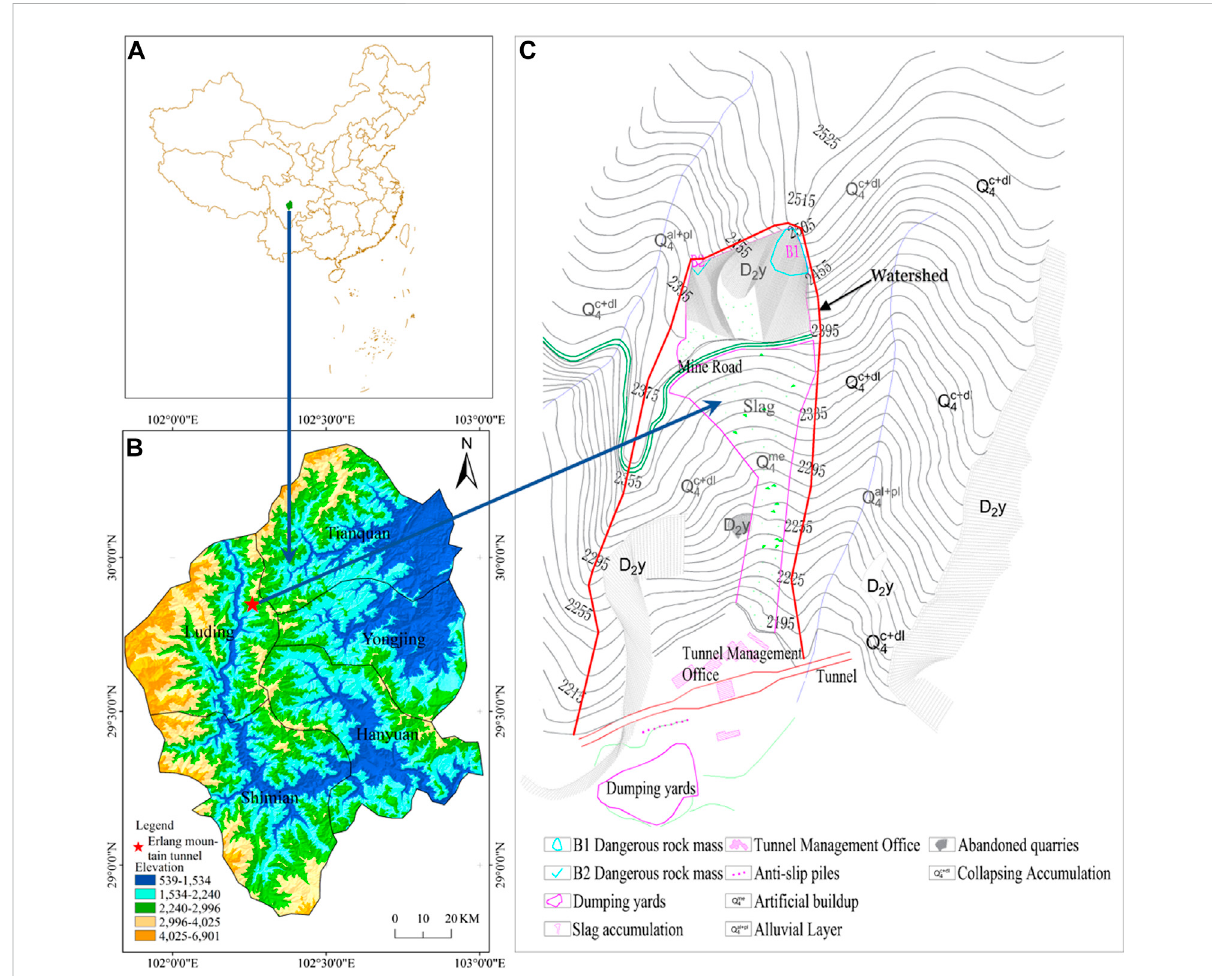
FIGURE 1 Distribution of debris fl ow basin on the back hillside of the Erlang Mountain Tunnel Management Of fi ce. (A) Location within China, (B) Location within Sichuan Province, (C) Location of the back hillside of Erlang Mountain Tunnel Management Of fi ce, and the surrounding environment